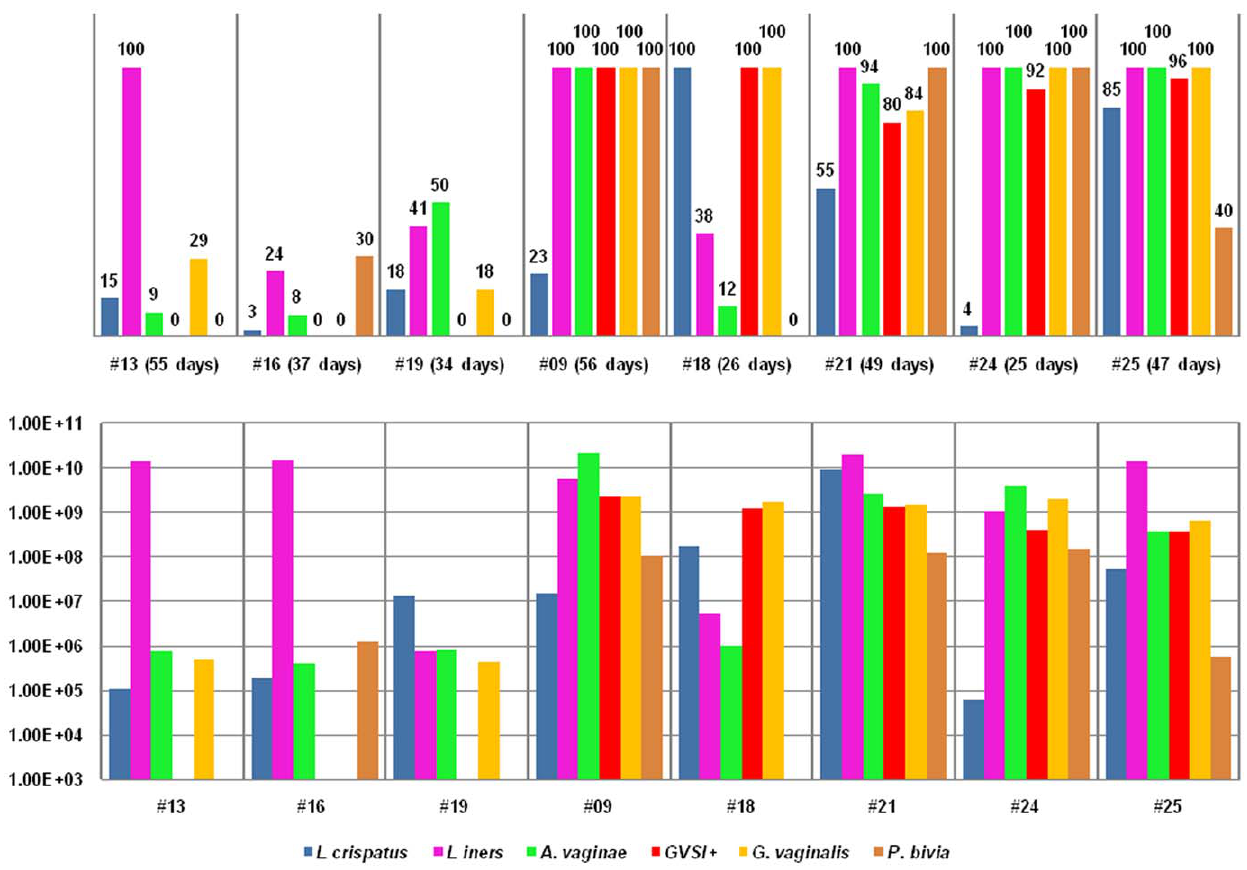
Figure 2. The presence and average concentrations of the 5 species during the study in group D. Legend: The chart above represents the total presence (%) of the 5 species during the days that were analysed. In addition, the actual days present versus the total days analysed are also given. The chart below represents the average concentrations (cells/ml) of the 5 species during the days that were analysed.